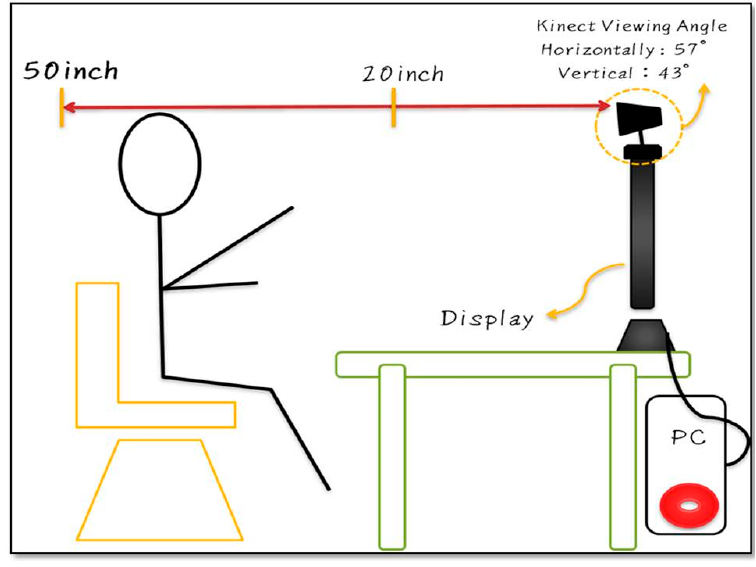
Figure 2. Conceptual lab setup.